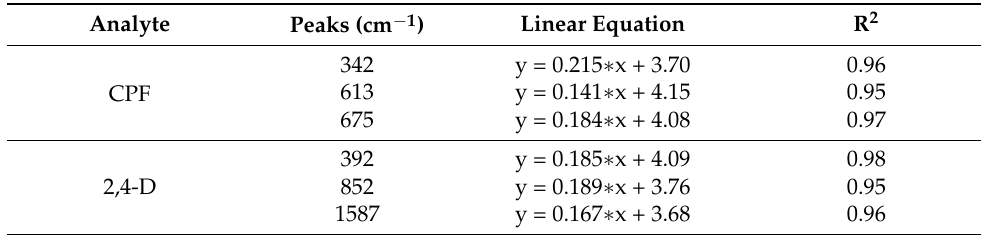
Table 2. Linear relationship between concentrations of CPF and 2,4-D standard solution and Raman intensities at characteristic